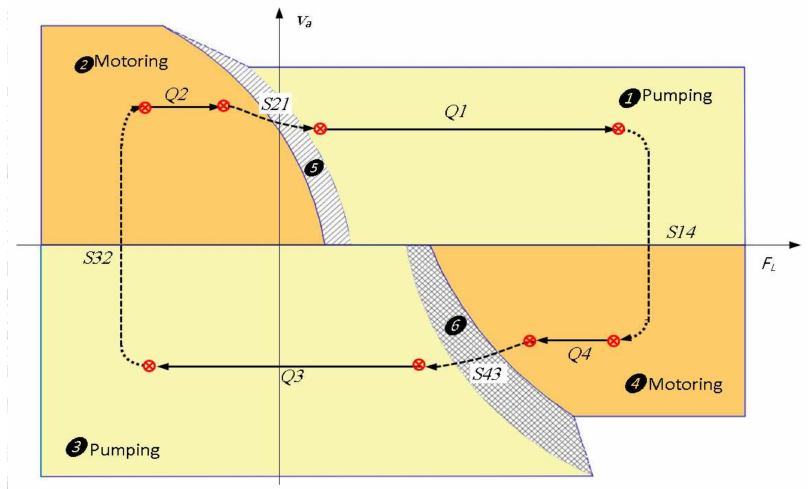
Figure 3. Desired operation of pump-controlled circuit in F L − v a